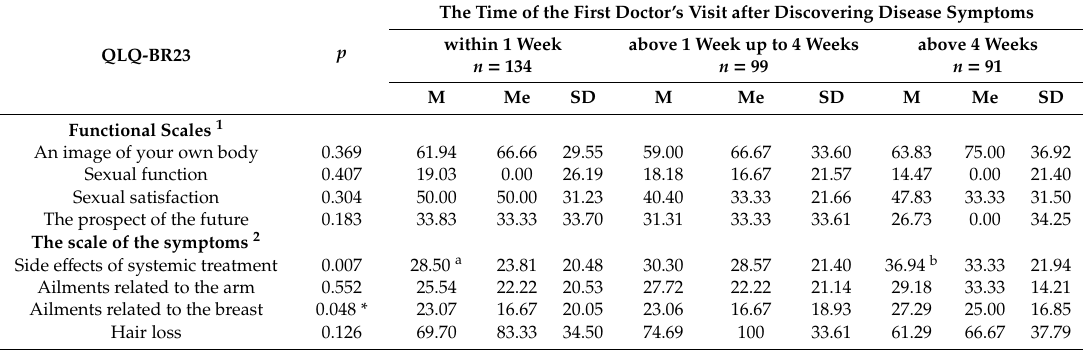
Table 6. Assessment of women’s quality of life—categories related to QLQ-BR23 and the time of the first doctor’s visit after discovering disease symptoms.